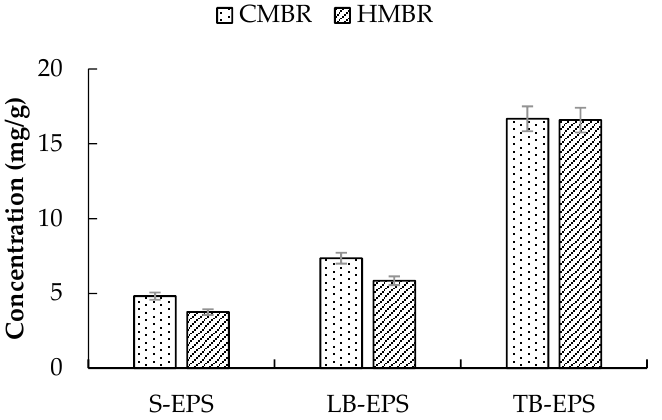
Figure 3. EPS distribution in the conventional membrane bioreactor (CMBR) and hybrid membrane bioreactor (HMBR).